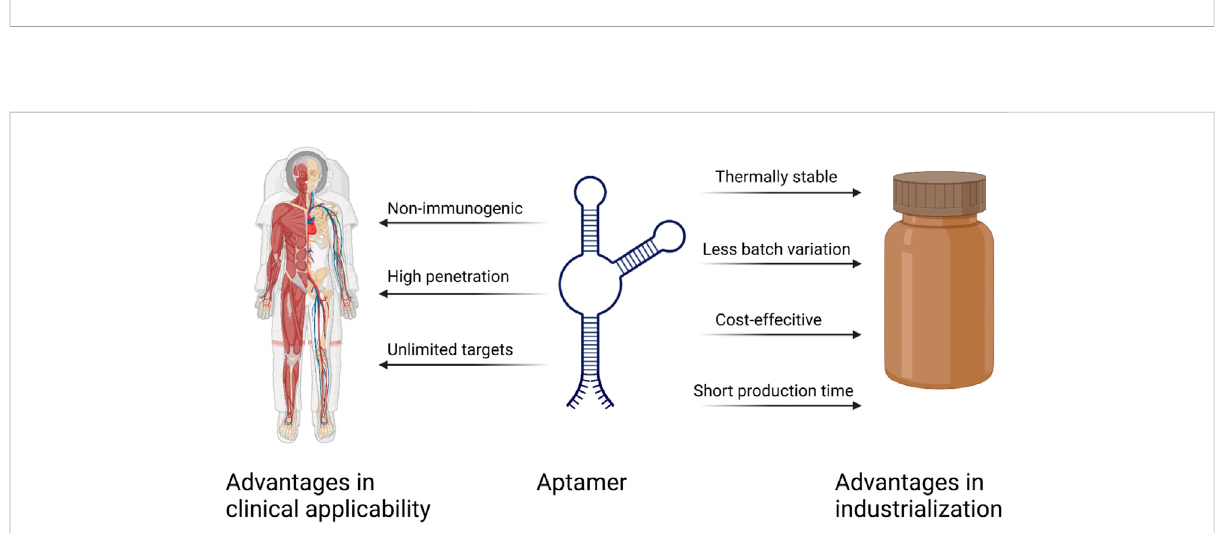
FIGURE 5 Important advantages of aptamers over antibodies (Sun and Zu,